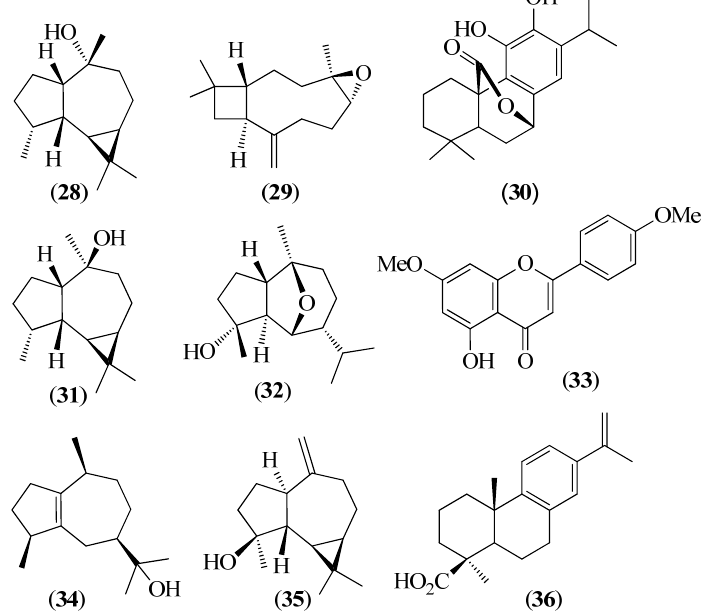
Figure 6. Structures of compounds 28 and 29 from Lepechinia heteromorpha ; 30 – 33 from L. mutica ; 28 – 30 and 34 from L. paniculata ; and 33 , 35 , and 36 from L. radula .